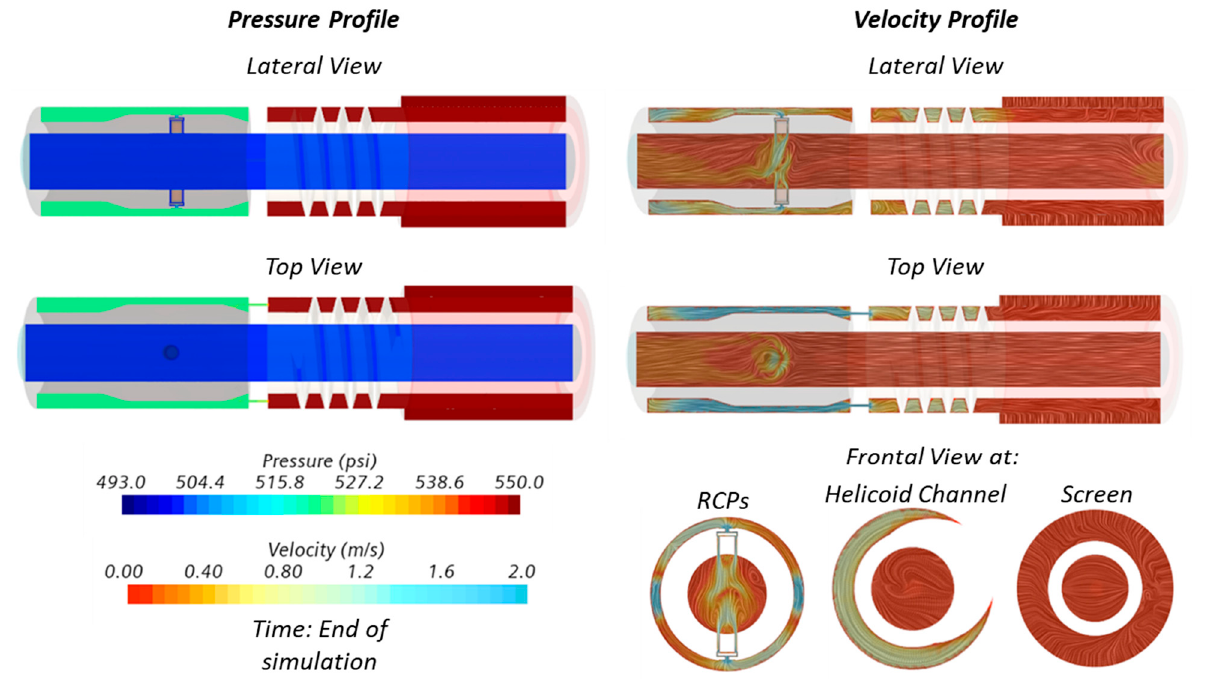
Figure 10. Hydrodynamic profile obtained for the complete AICD assembly at the end of the simulation time.